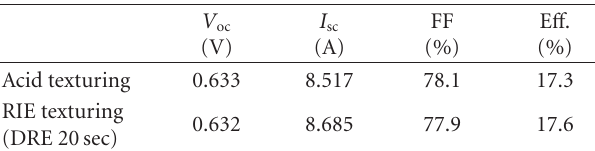
Figure 7: External quantum e ffi ciency (EQE) of selective emitter mc-Si solar cells with acidic- and RIE-textured surface. Table 2: The average electrical performance of selective emitter mc- Si solar cell with acidic and RIE